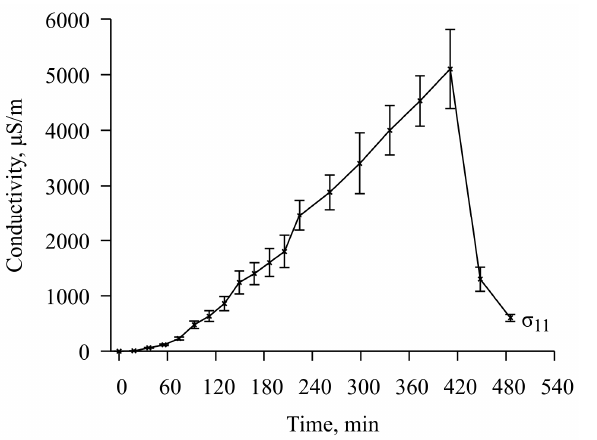
Figure 10. The results of fitting the values of the conductivity of the chitosan acetate film from the run time of the experiment.